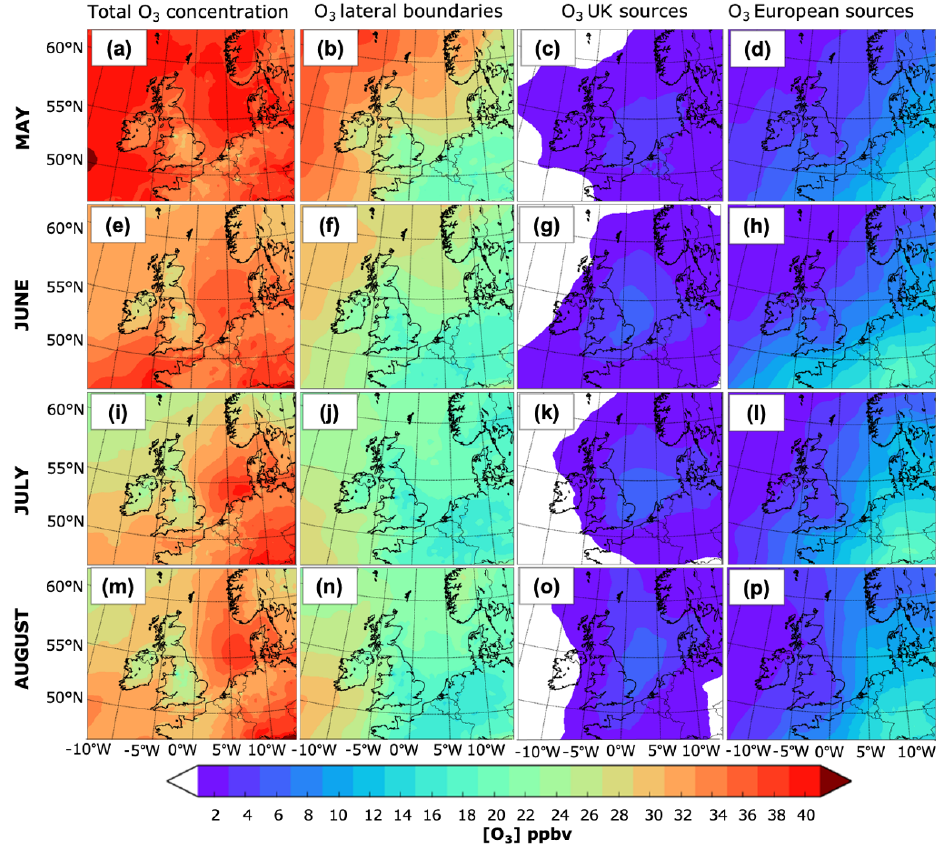
Figure 4. Spatial distribution of the monthly mean surface O 3 from May to August 2015. The first column depicts the mean O 3 mixing ratio in May, June, July, and August; the absolute monthly contribution from the lateral boundaries is shown in the second column; the third column shows the contribution from UK emissions; and the contribution from the Eu super-region, which includes emissions from the main shipping routes over the European seas and the Atlantic, is presented in the fourth column.